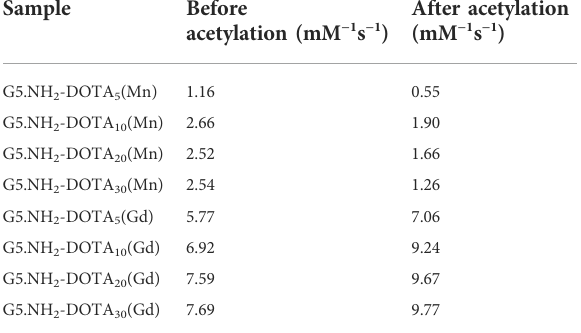
TABLE 1 Linear fi tting of the r 1 relaxivities of G5.NH 2 -DOTA(Mn) and G5.NH 2 -DOTA(Gd)beforeandafteracetylationasfunctionsofMn and Gd concentrations, respectively.